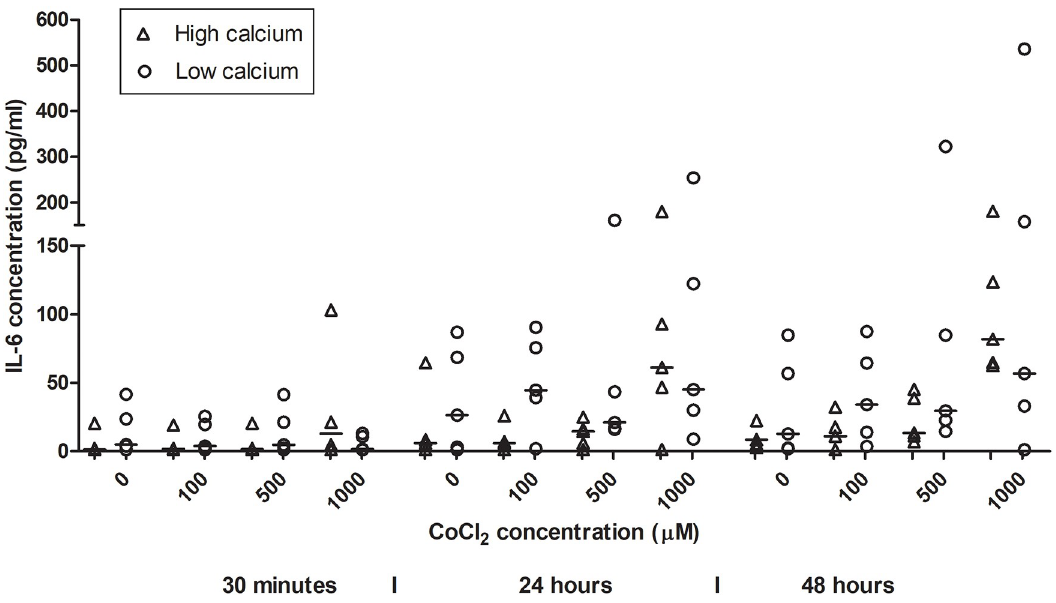
Fig 3. IL-6 secretion from HaCaT cells after exposure to cobalt chloride. HaCaT cells were exposed to cobalt chloride concentrations are 100, 500 and 1000 μ M and an unexposed control (0 μ M). Exposure times are 30 minutes, 24 hours and 48 hours and calcium incubation of HaCaT cells in high (1.8 mM) and low (0.15 mM) calcium concentrations are used. The secretion of IL-6 increased over time and with increasing cobalt chloride